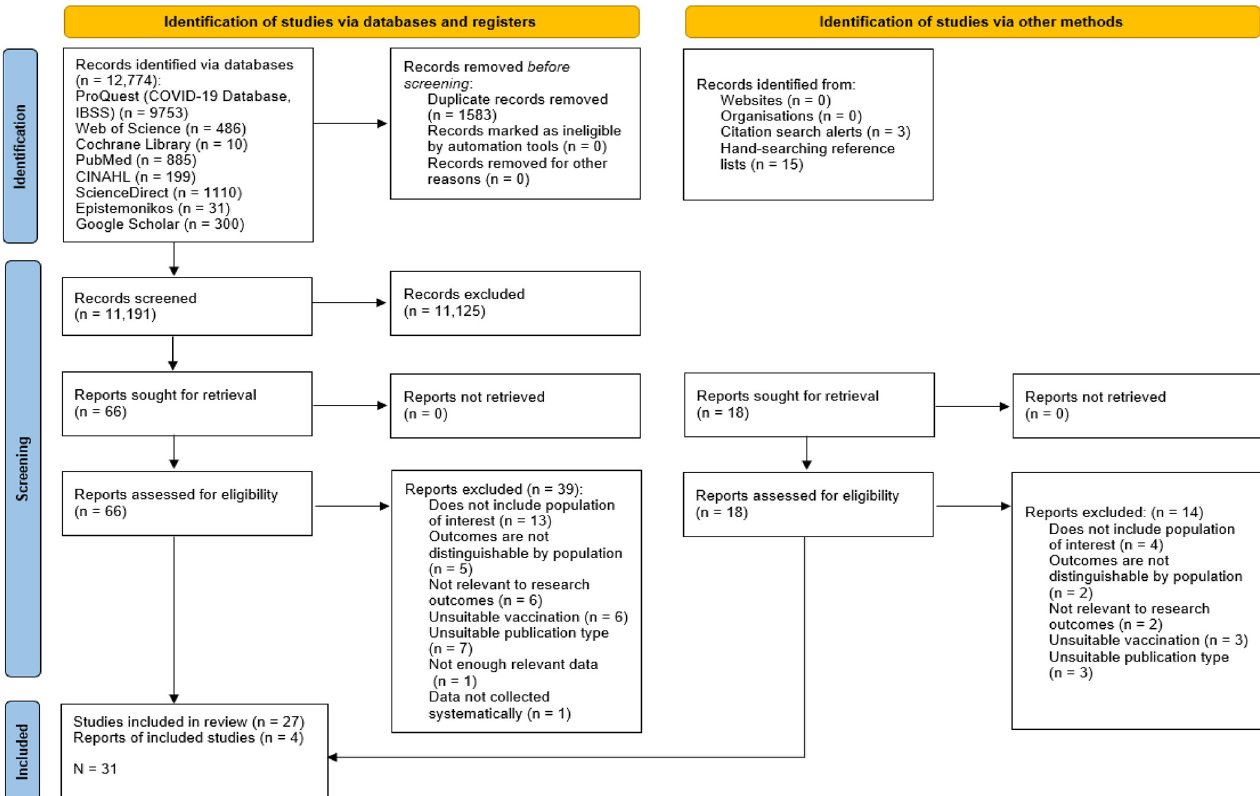
Fig 1. PRISMA flowchart [12] detailing the identification and selection of research syntheses for inclusion in the Umbrella Review.